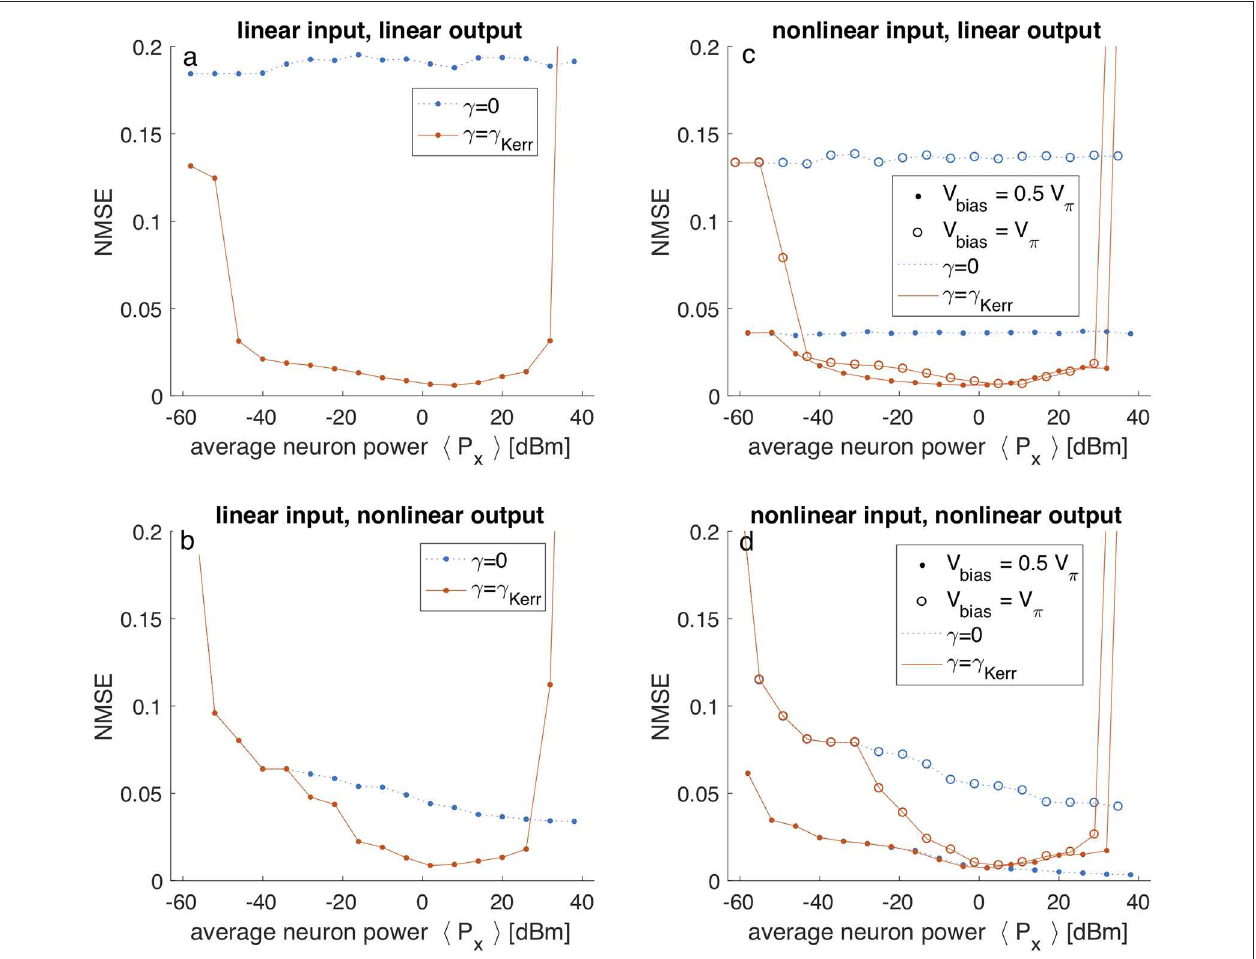
FIGURE 4 | Numerical results of fiber-ring reservoir computer on Santa Fe time series prediction tasks. In all panels the prediction error (NMSE) is plotted vs. the P x average neuron power . (a,b) Correspond with a linear input layer, where (c,d) correspond with a non-linear input layer using the MZM’s non-linear transfer h i function. The non-linear input regime shows results for two different operating points of the MZM with different strengths of non-linear transformation. (a,c) Correspond with a linear output layer, where (b,d) correspond with a non-linear output layer using the